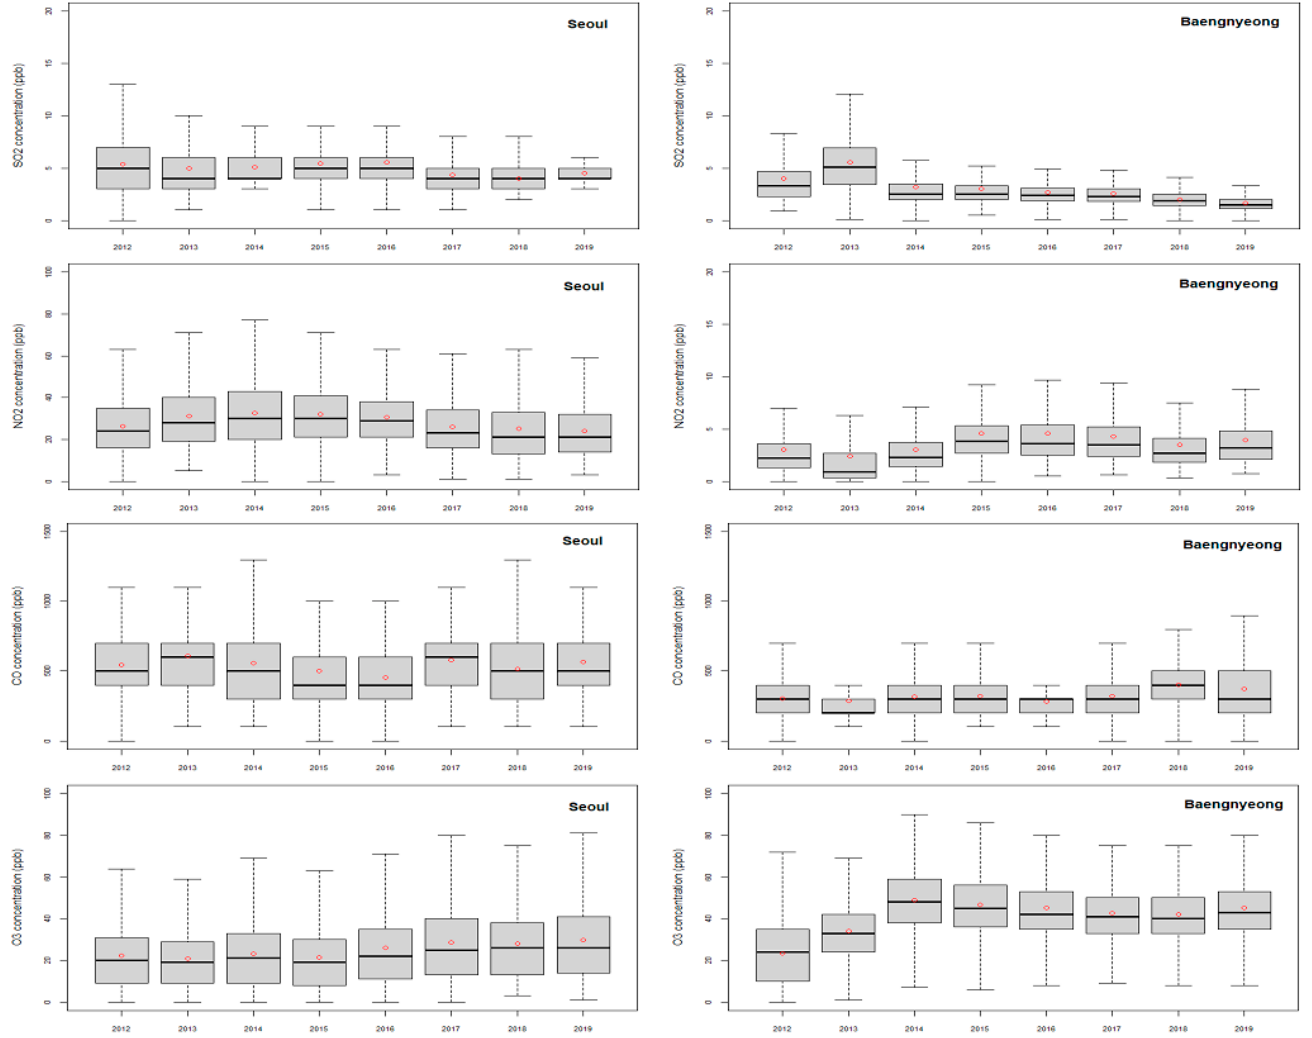
Figure 2. The annual levels of gaseous species. The annual mean (red circle), minimum, interquartile range (Q1), median, interquartile range (Q3) and maximum values are shown.